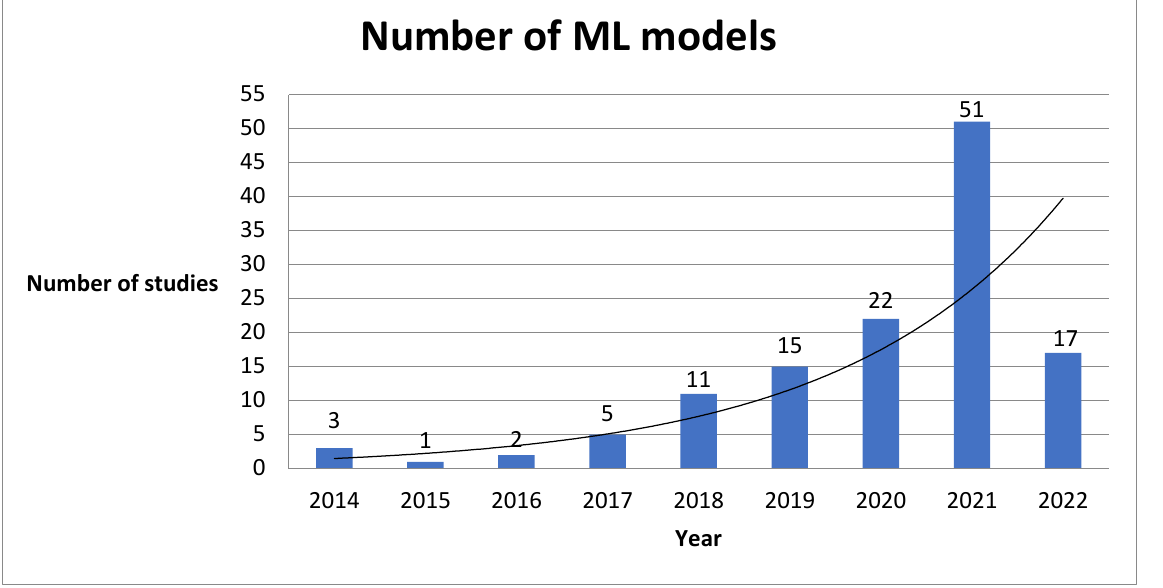
Figure 3. Number of ML predictive models created during last 9 years.